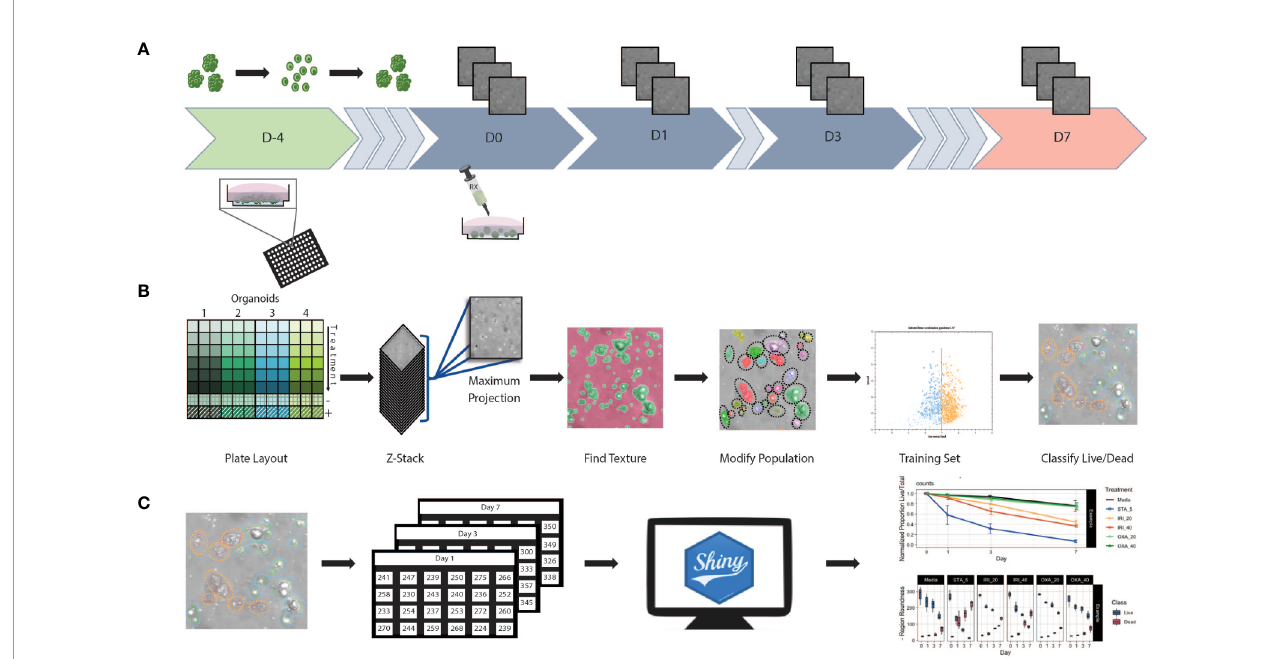
FIGURE 1 | Work fl ow schematic (A) At day -4 organoids were digested to single cells and seeded at 5,000 cells/well in Basement Membrane Extract. Plates were incubated for 4 days allowing organoids to reform. Baseline images were taken at day 0 prior to the initiation of treatment. After initial treatment, plates were re- imaged at days 1, 3, and 7. Media and treatment are refreshed post imaging on day 3, with fi nal measurements taken at day 7. (B) Using 96 well plates, multiple patients and/or treatments can be performed with a single assay. Images were obtained in z-stack then combined into a single maximum projection image upon which all further processing and analysis was performed. A textural algorithm was used to identify organoid regions of interest, with a segmenting algorithm applied to split organoids in near proximity to each other. A training set was created by identifying live/dead organoids across untreated and treated samples from each patient. This supervised machine learning algorithm was then applied to experimental data. (C) Classi fi cation data was compiled into spreadsheets then uploaded to a web-based app for data processing and